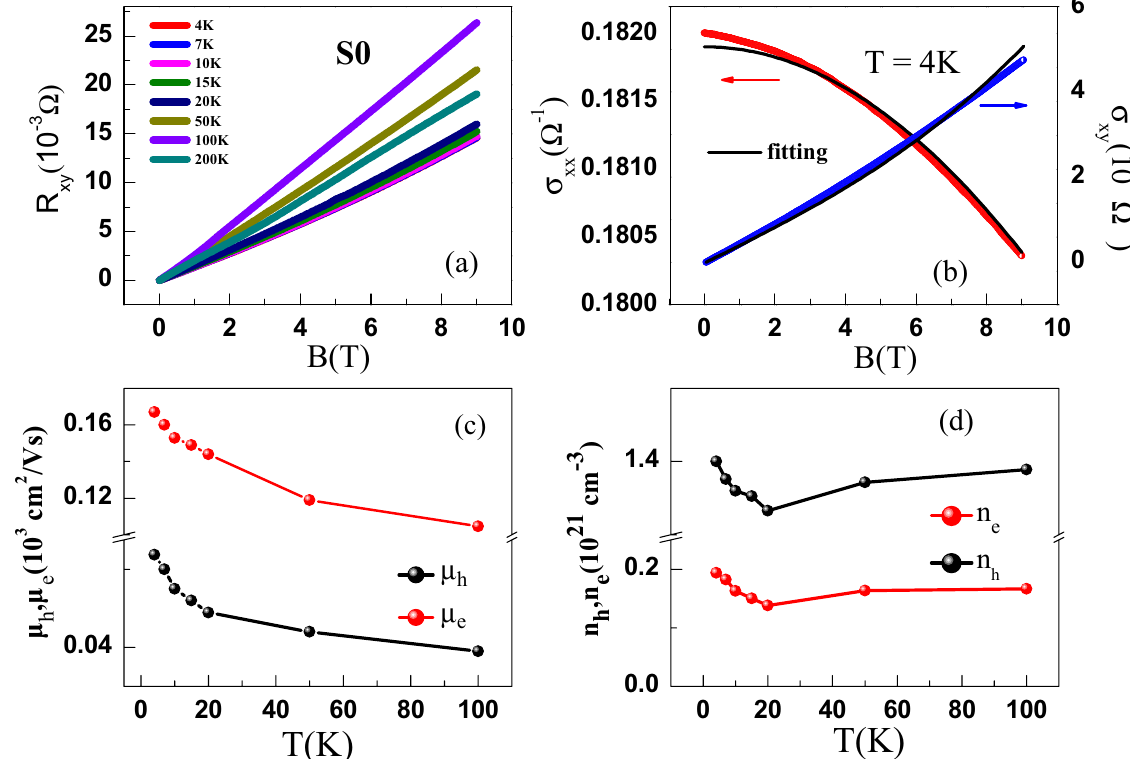
Figure 4. ( a ) Hall resistance (R xy ) vs magnetic field ( B ) at various temperatures for S0 thin film of PBS. ( b ) Variation of Hall conductance ( σ xy ) and longitudinal conductance ( σ xx ) as a function of B at T curves through the data are the global fitting of the σ xy and σ xx by a two-band model (see text for details). ( c ) Temperature dependence of mobility and ( d ) carrier density of electron and hole carriers in S0. The solid curves through the data in ( c ) and ( d ) are guides to the eye.